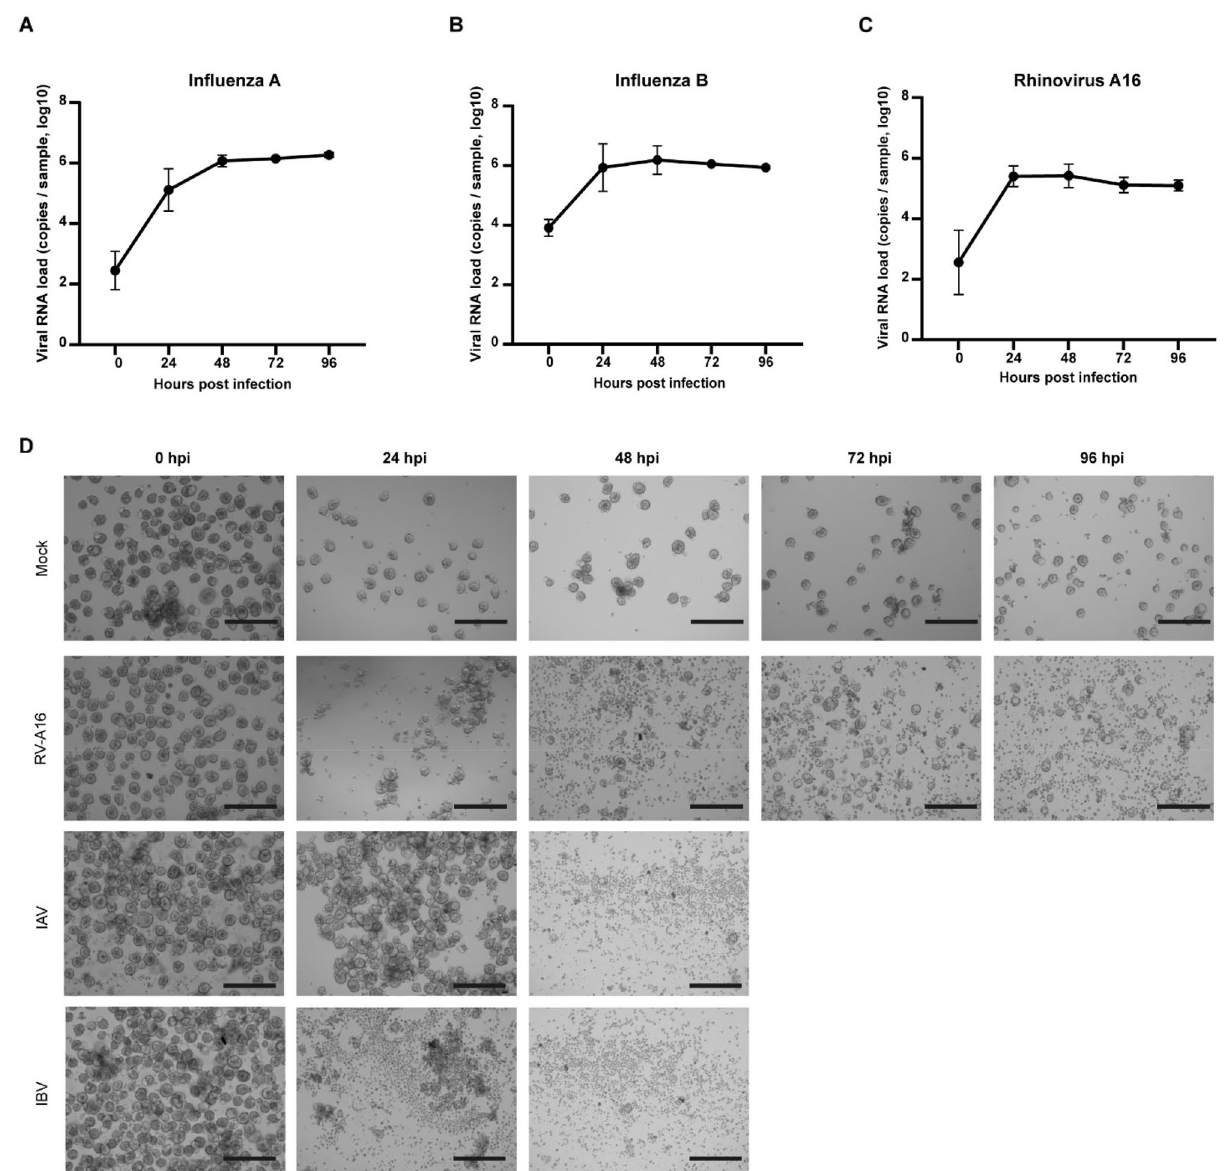
Figure 4. Ap-O AO are susceptible to infection with RV-A16, IAV and IBV. Viral load of IAV ( A ), IBV ( B ) and RV-A16 ( C ) detected by qPCR in the supernatant. Apical-out airway organoids show susceptibility to